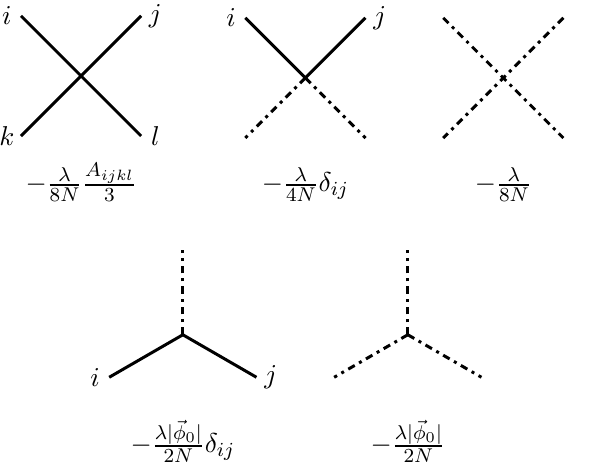
Figure 2 . Vertices. The factor A ijkl / 3 = ( δ ij δ kl + δ ik δ jl + δ il δ jk ) / 3 in the first vertex accounts for the possible permutations of the